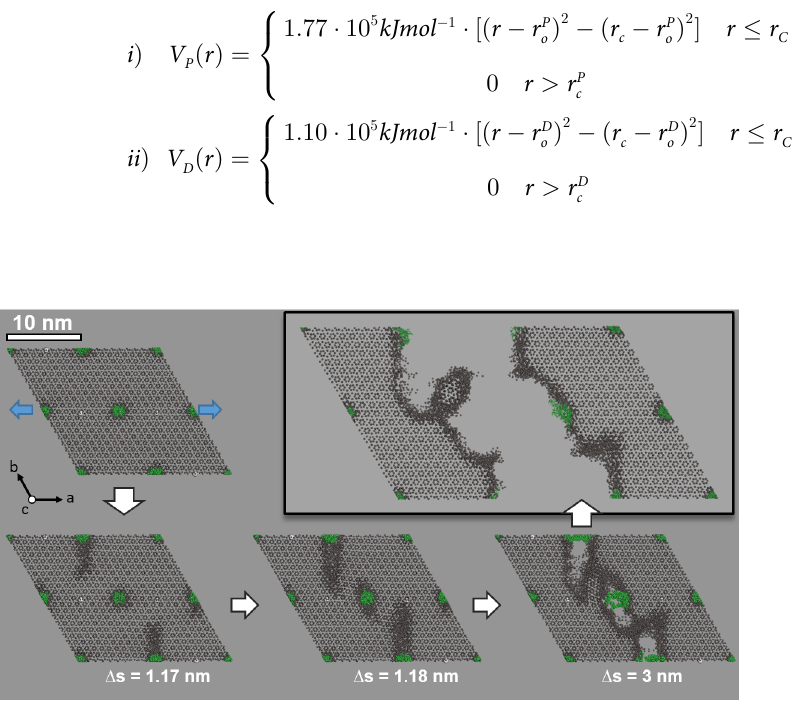
Fig 1. Atomistic simulation model mimicking the composite material at the nanometer length scale. While the overall model comprises 212.340 atoms, only calcium ions (grey) and the backbone of the collagen triple-helices (green) are shown. Using 3-dimensional periodic boundary conditions, the system is stretched (blue arrows) along the a-axis to induce fracture (which occurs at Δ s (cid:6) 3.5 nm). Plastic deformation preferentially occurs at the organic-inorganic interface and gives rise to rough fracture patterns that are determined by the arrangement of the proteins within the